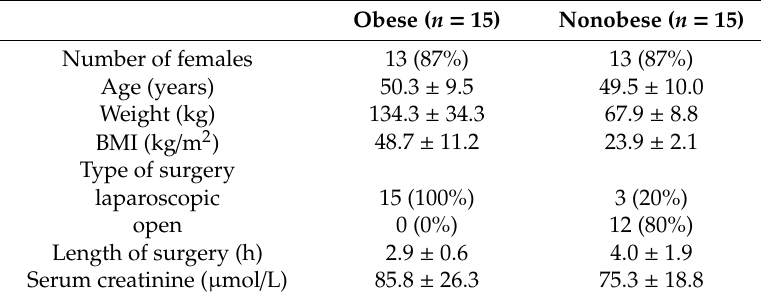
Figure 1. CONSORT flow diagram. BMI = body mass index. Table 1. Demographic and clinical characteristics.